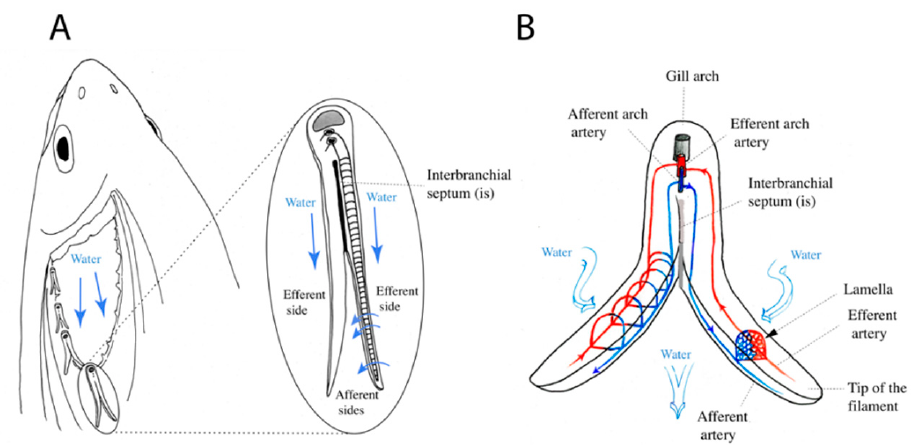
Figure 1. Schematic view of teleost fish gills. ( A ) Individual gill arches each offering support to two rows of gill filaments in alternate positions, forming a sieve-like arrangement. Filaments are supported by interbranchial septa of which the length varies with the species. The septum is most reduced in modern teleosts. ( B ) Schematic representation showing that gill filaments are compartmentalized into an a ff erent and an e ff erent side, with bloodstream from the a ff erent (oxygen-deprived blood) to the e ff erent side (oxygenated blood) and water circulating in the opposite direction.